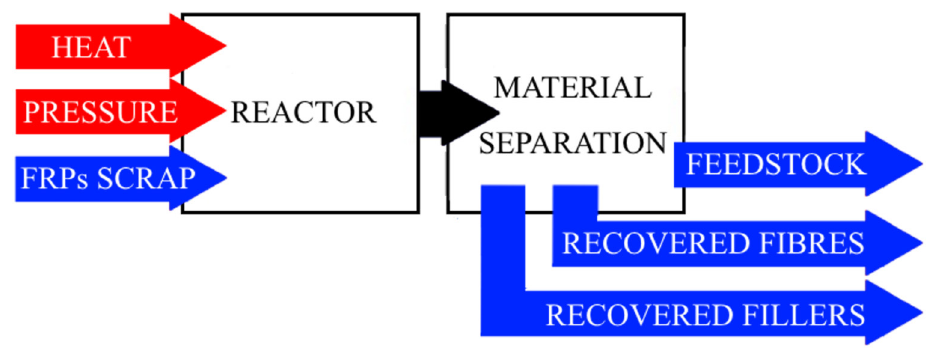
Figure 4. Schematisation of a generic chemical recycle.